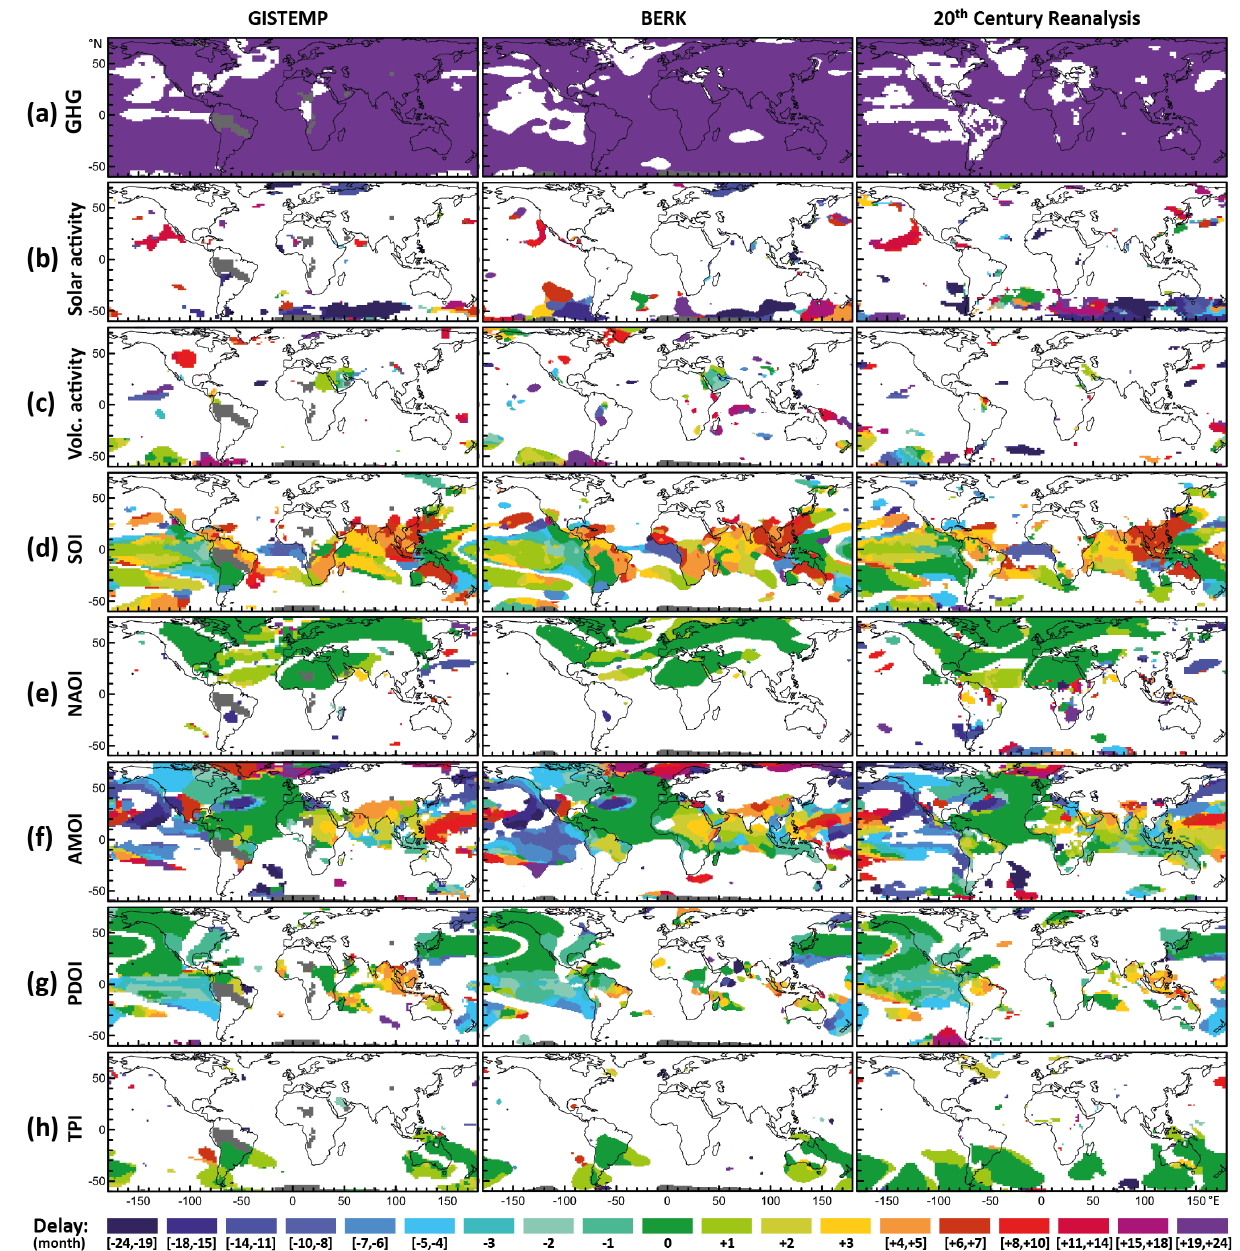
Figure 6. Geographic distribution of the predictor offset time (cid:49)t for which the strongest local temperature response was detected, within the ± 24 month range. Positive values of (cid:49)t correspond to setups with predictor leading temperature; only grid points with response statistically significant at the 99% level are shown. See Fig. 7 for the corresponding values of the temperature